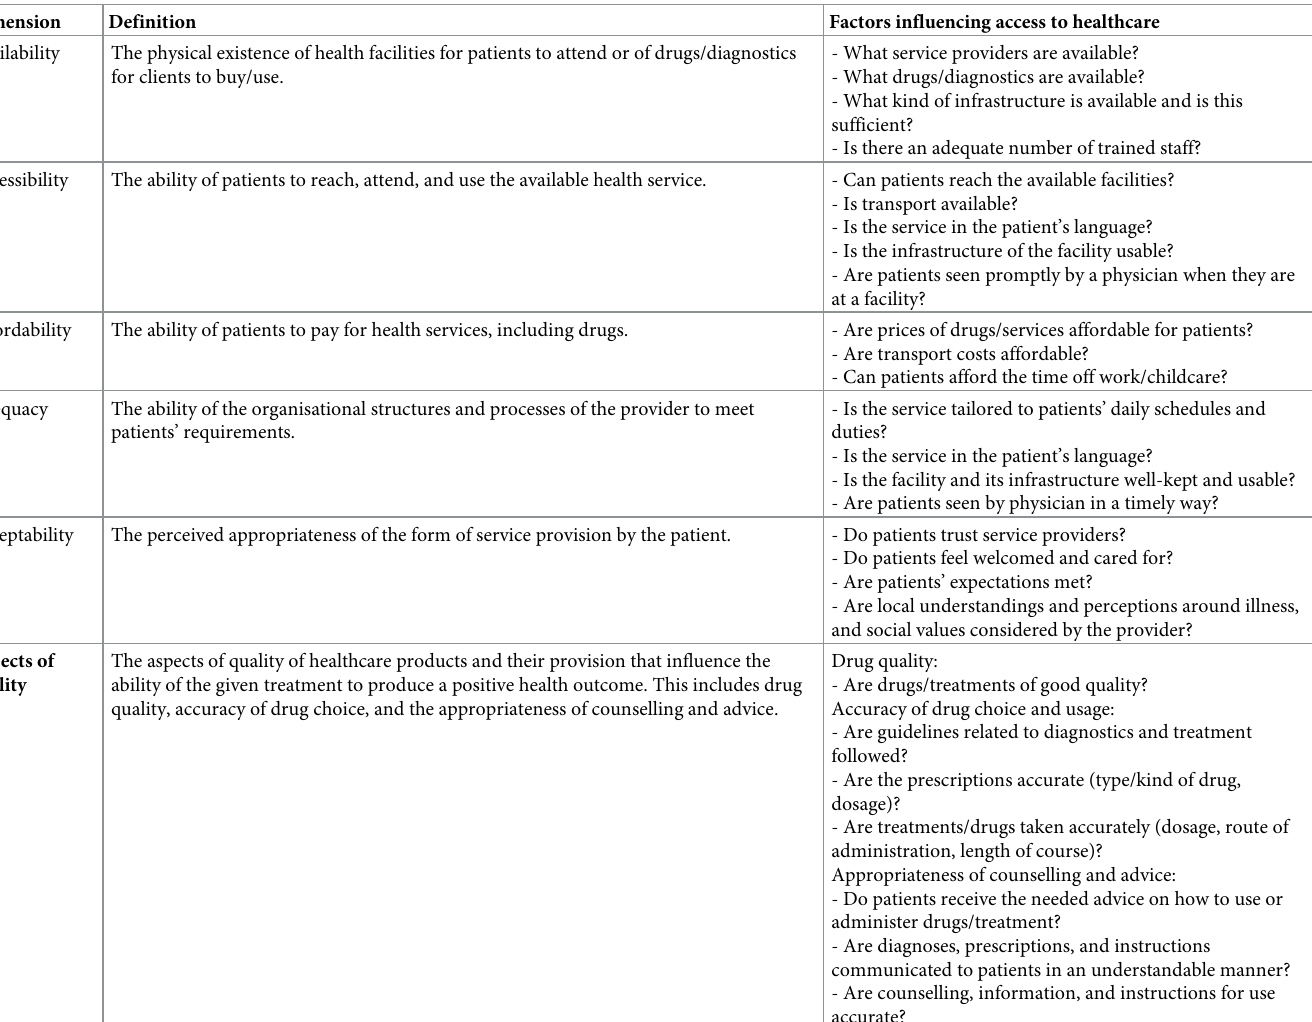
Table 1. Definitions of the 5 dimensions of access to quality healthcare (availability, accessibility, affordability, adequacy, and acceptability) adapted from Obrist and colleagues (2007) [12] but expanded to include a sixth dimension that we define “aspects of quality” (in bold) to account for aspects of quality and accuracy of treatment and